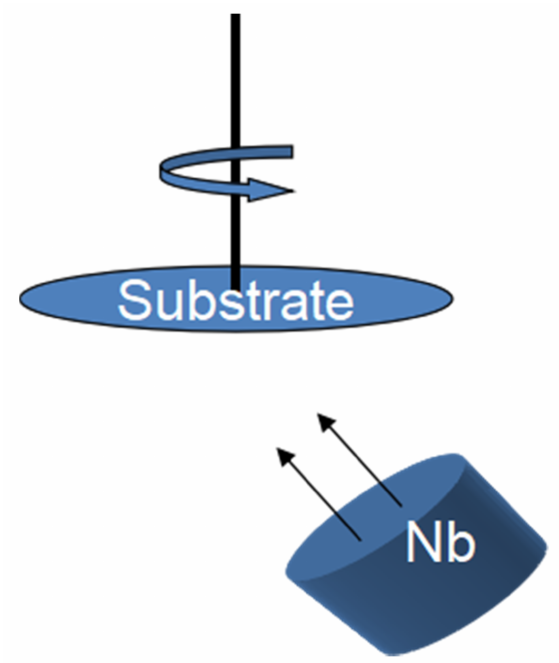
Figure 1. A brief overview of the sample